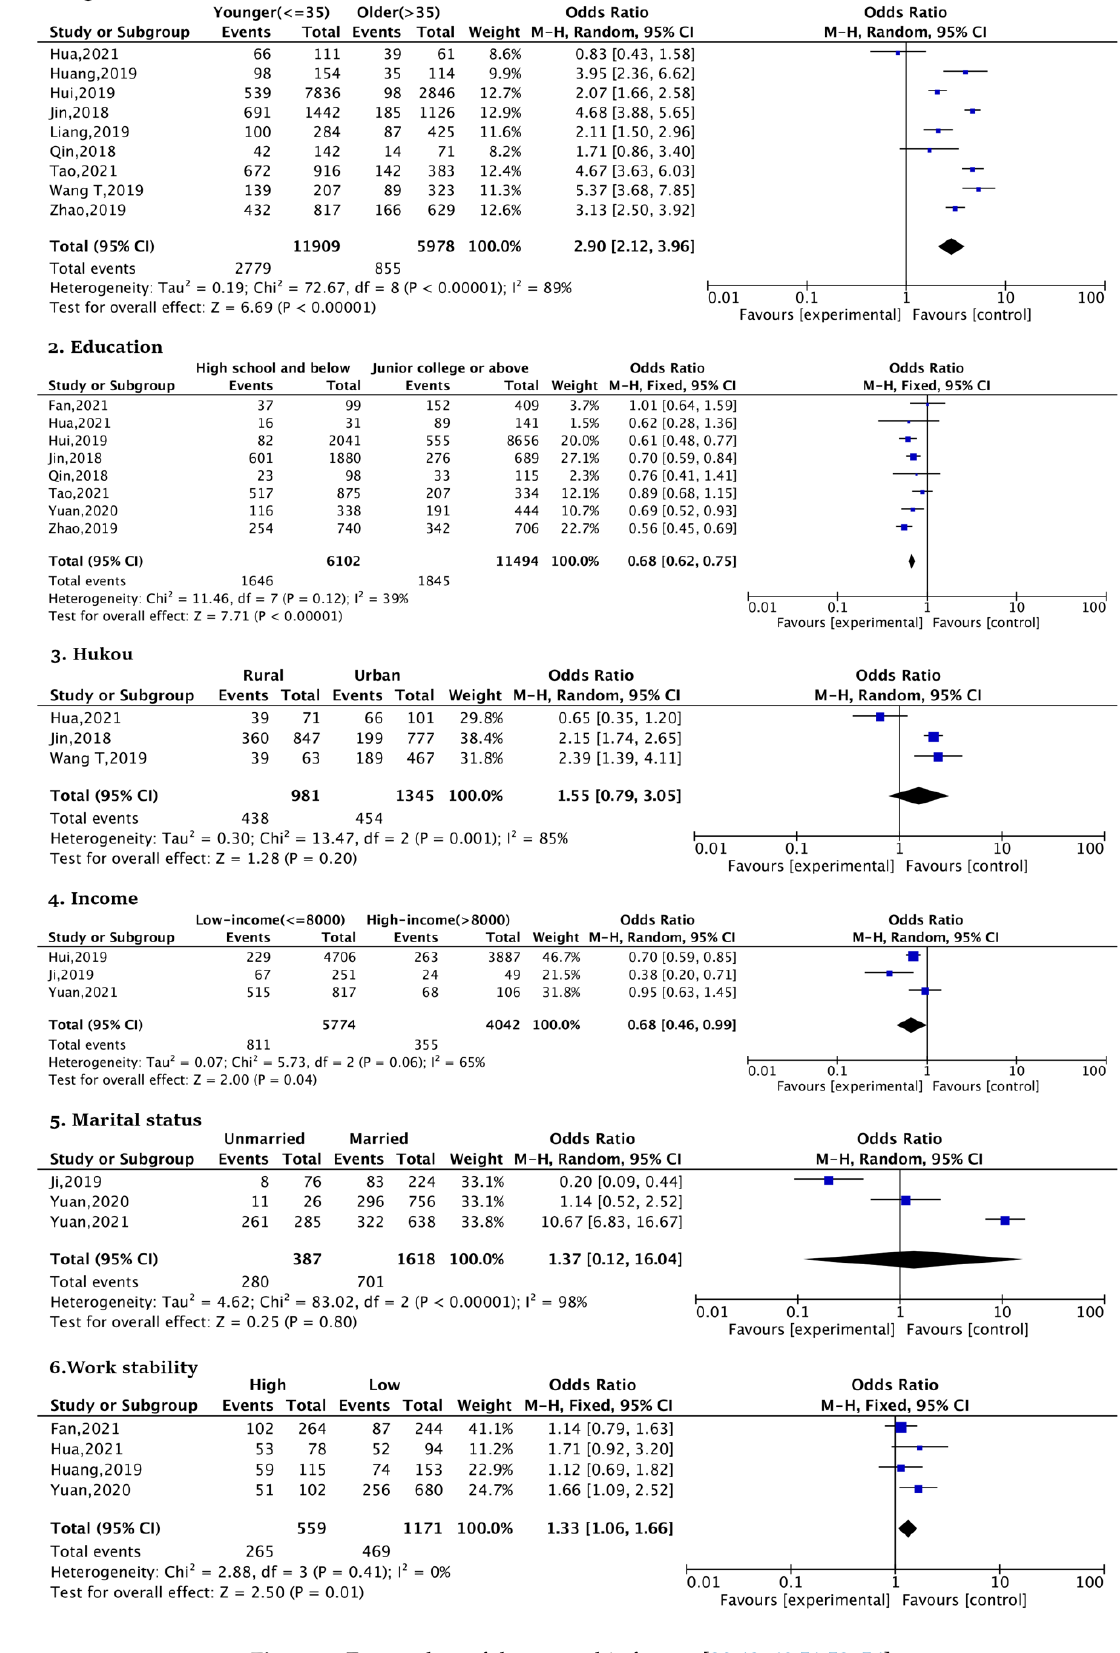
Figure 2. Forest plots of demographic factors.